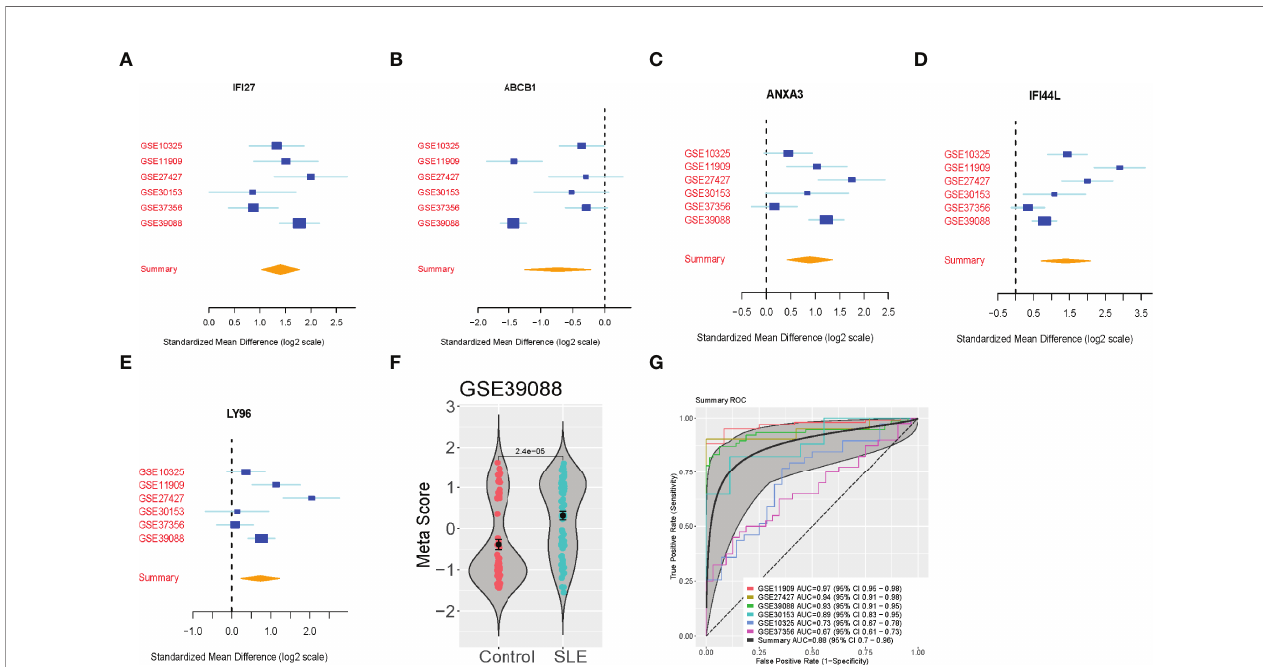
FIGURE 2 | Validation of the 5-Gene signature diagnosis of SLE. (A – E) The up-regulated genes and down-regulated genes in independent validation cohorts. (F) A representative violin plot illustrating the performance of the fi ve-gene signature to differentiate SLE from Control in one of the discovery cohorts (GSE39088). The Wilcoxon p value and error bars are shown. (G) ROC curves of patients with SLE versus controls in six independent validation cohorts.